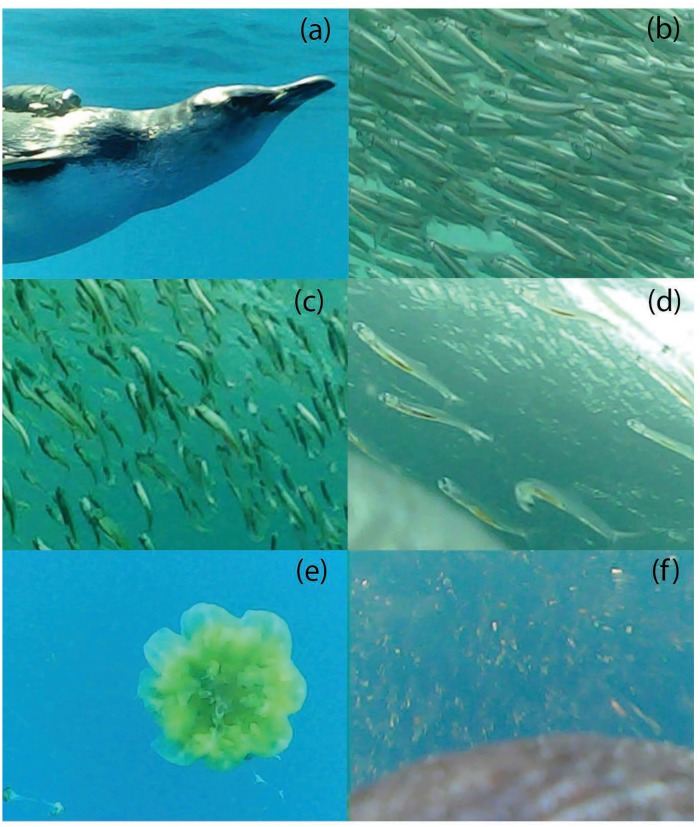
Representative images of the types of little penguin foraging data obtained during this study: (a) conspecific showing position of camera package; (b) southern anchovy, (c) sandy sprat, (d) juvenile Clupeiformes, (e) Cyaneidae jellyfish and (f) coastal krill.